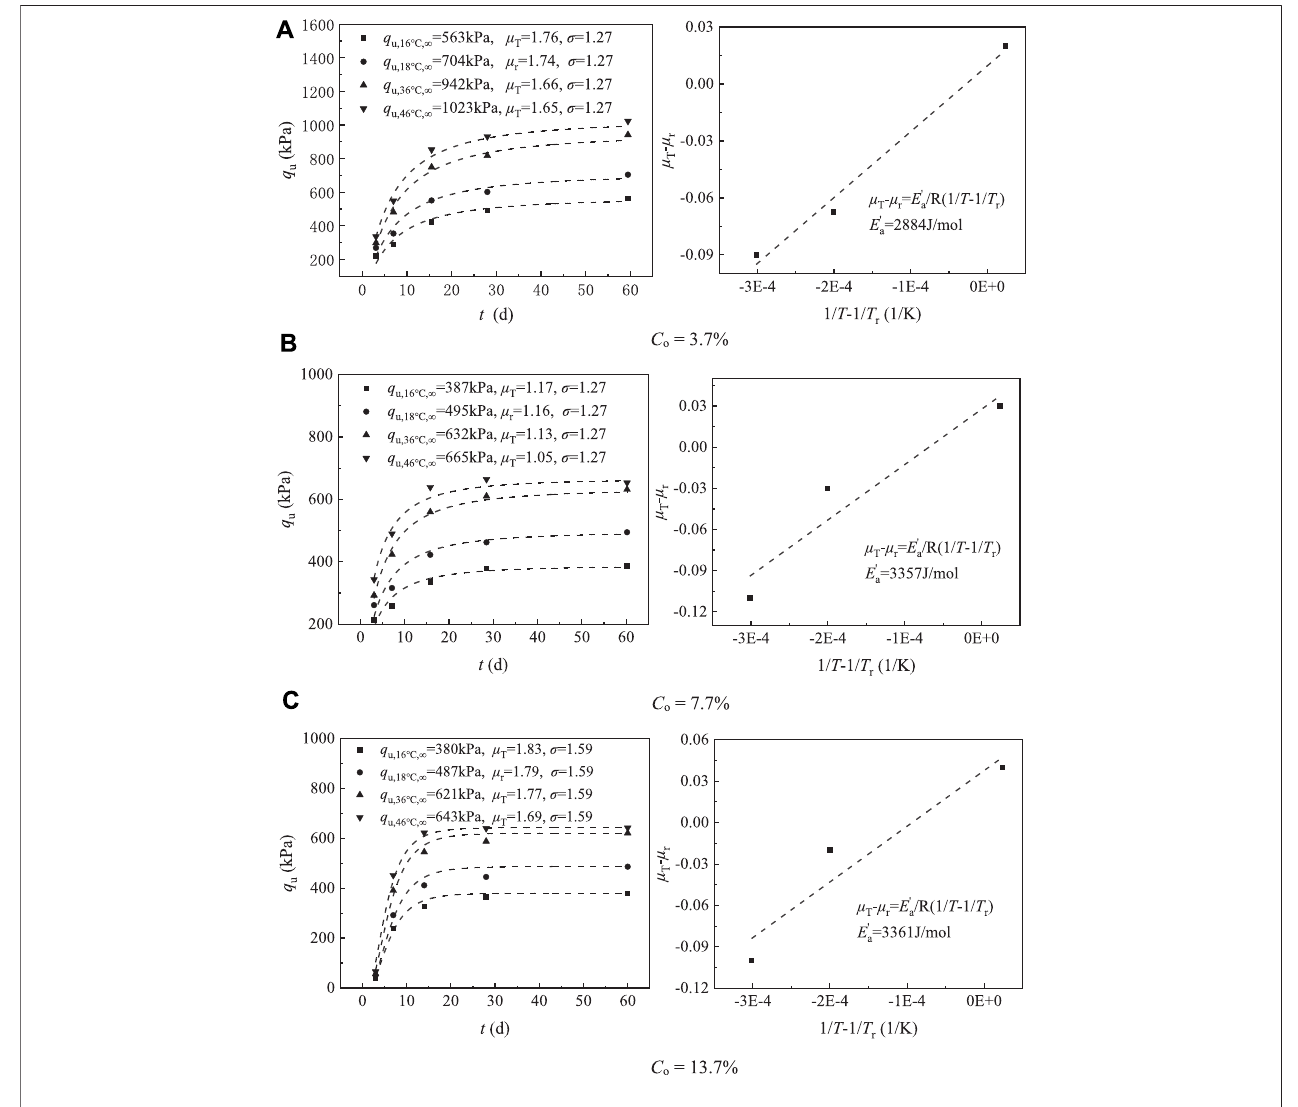
FIGURE 8 | Strength development curves of CSC samples affected by temperature. (A) C o = 3.7% (B) C o = 7.7% (C) C o = 13.7%.